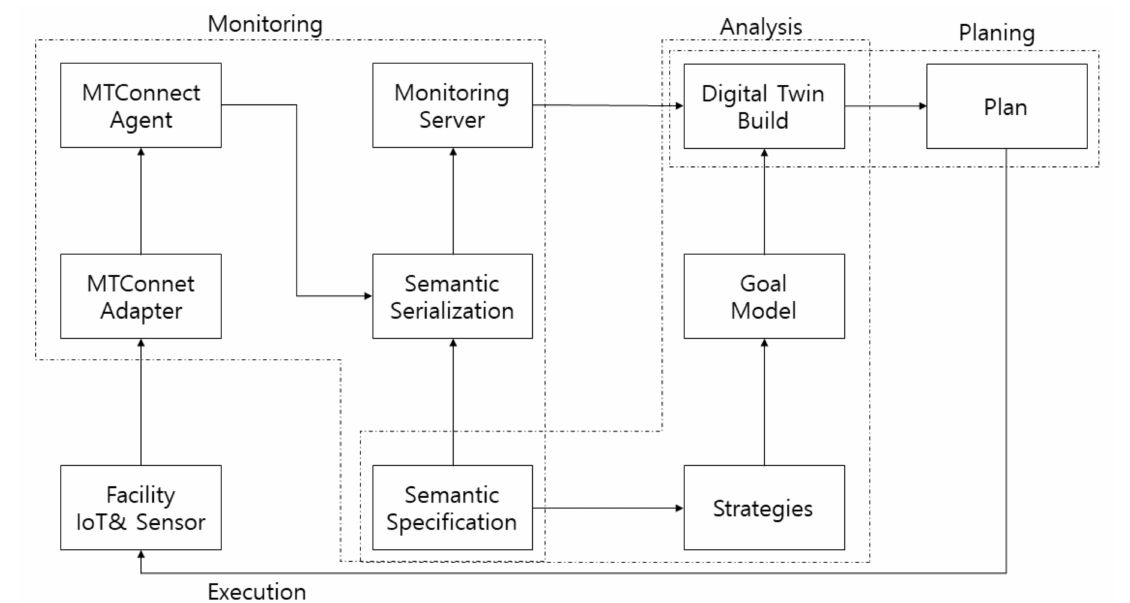
Figure 10. Semantic-based autonomous computing technology